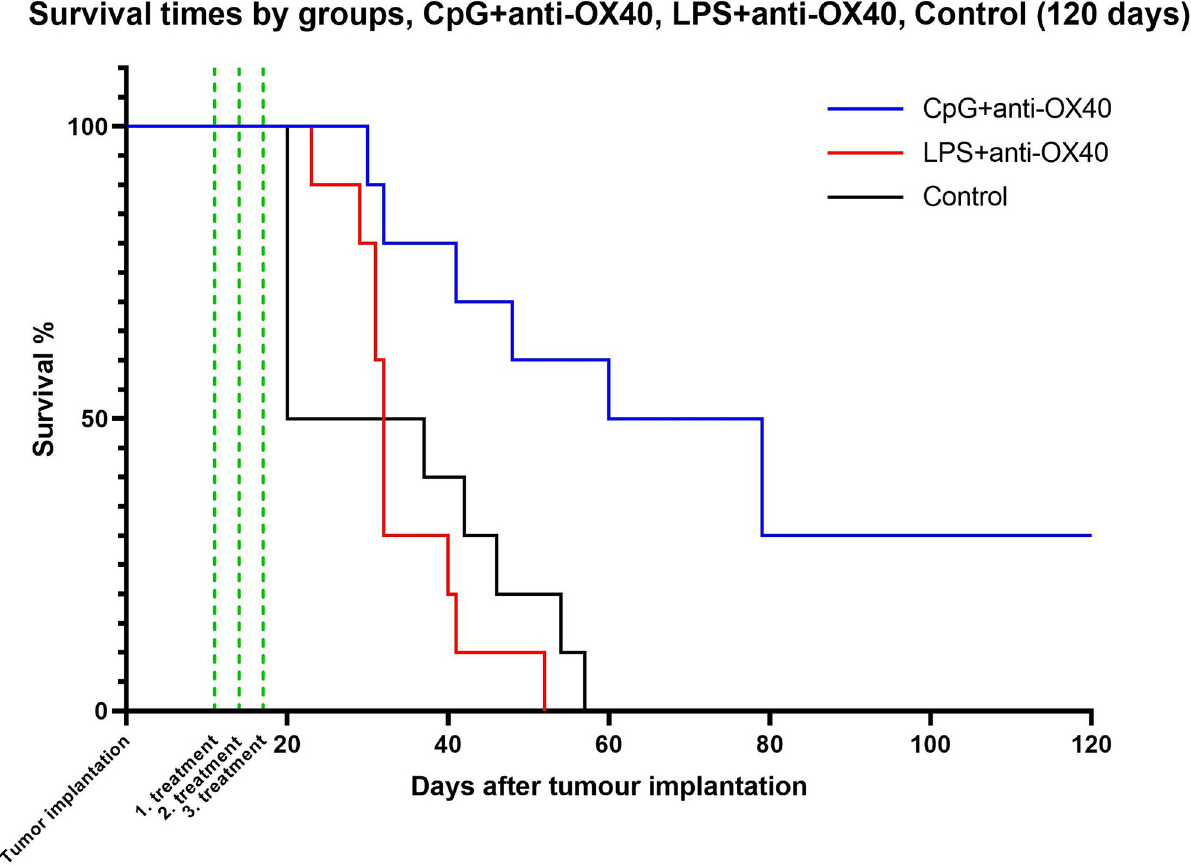
Fig 1. Timeline of the experiment including tumor implantation, treatments and survival times in the different groups. We have found significant differences between the CpG + anti-OX40 treated group and both the control and LPS + anti-OX40 treated groups.